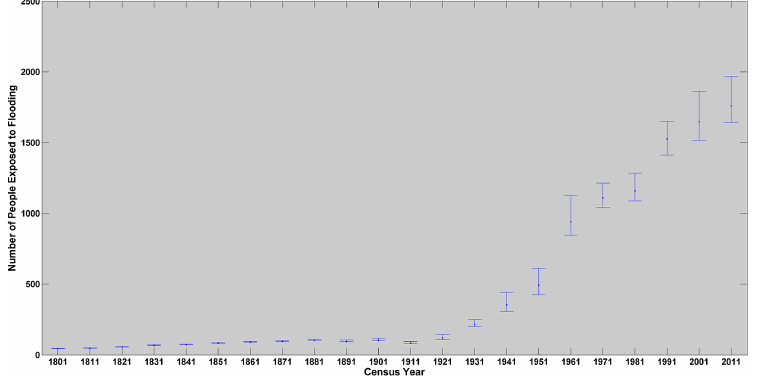
Figure 8. Estimated number of people exposed to flooding in Hayling (1 in 200 year recurrence interval, no defences). Error bars represent uncertainty in estimated rate of sea level change, population distribution and population